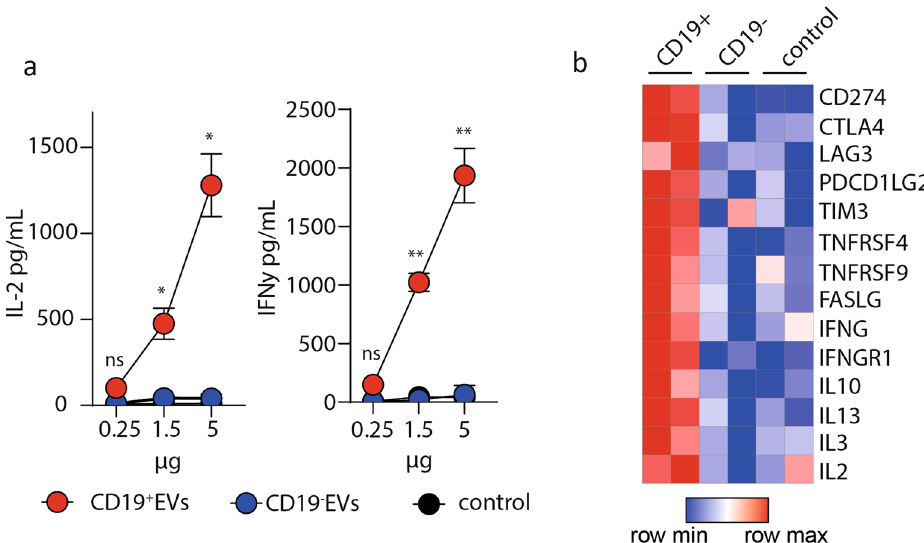
Figure 3. CD19-positive exosomes activate CAR T cells. A IFN-γ and IL-2 secretion by CD19-CAR T cells cultured in the presence of increasing concentrations of CD19 + or CD19 − EVs. Analysis of IFN-γ and IL-2 secretion by CD19-CAR T cells in the absence of stimulation is shown as control. Data are presented as the mean ± SD of three experimental replicates in at least two independent experiments. Statistical analysis was performed using two-way ANOVA with Tukey’s multiple comparison test. B Targeted multiplex analysis of CD19-CAR T cells (n = 2) treated with CD19 + or CD19 − EVs. Untreated CD19-CAR T cells were used as a control. Heatmap represents genes with highest (red) and lowest (blue) expression ( p value < 0.01, fold change > 1.5). Color key indicates the changes of normalized expression